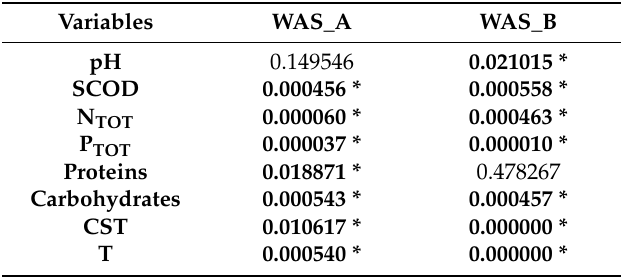
Table A1. The results of T -Test—direct